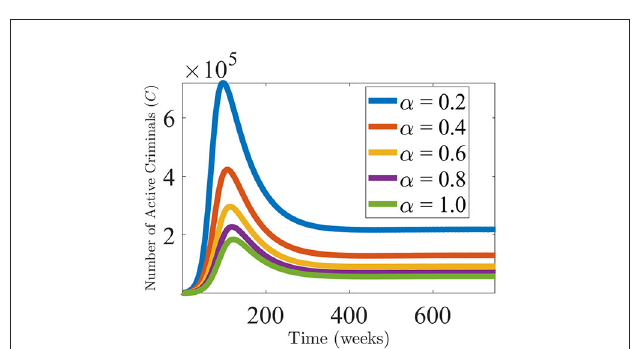
FIGURE3 Effect of varying the incarceration rate α on the criminal population. Simulation displaying the active criminal population, as a function of time. The values of the parameters are used from Tables 3, 4 with the values of α being